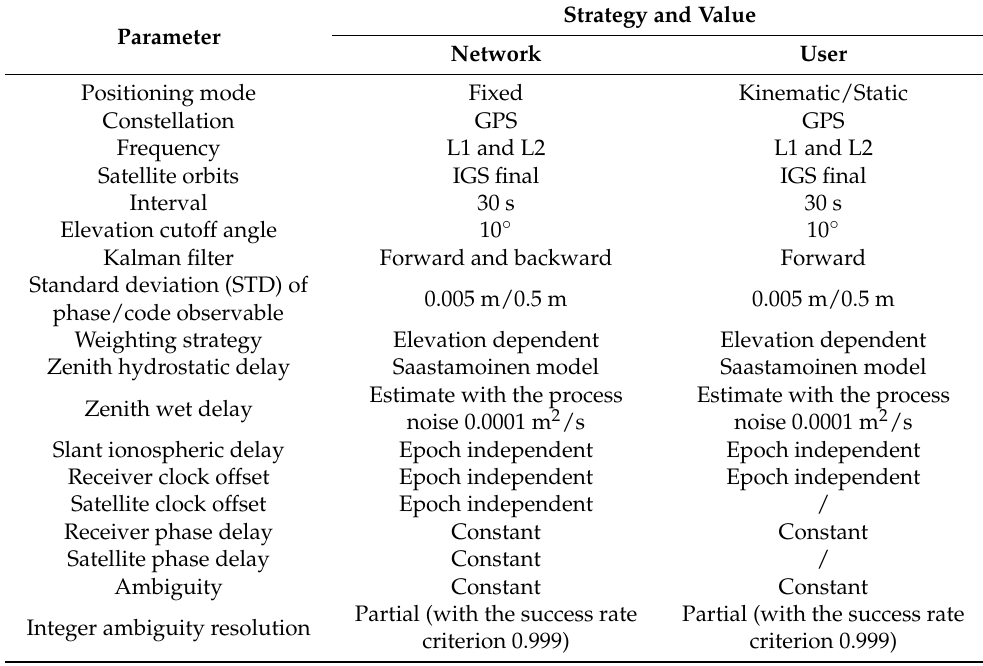
Table 1. Summary of the strategy of data processing for data